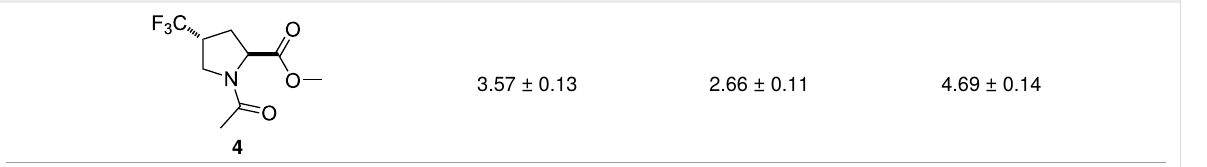
Table 2: Amide-rotation equilibrium in the model compounds. a (continued)